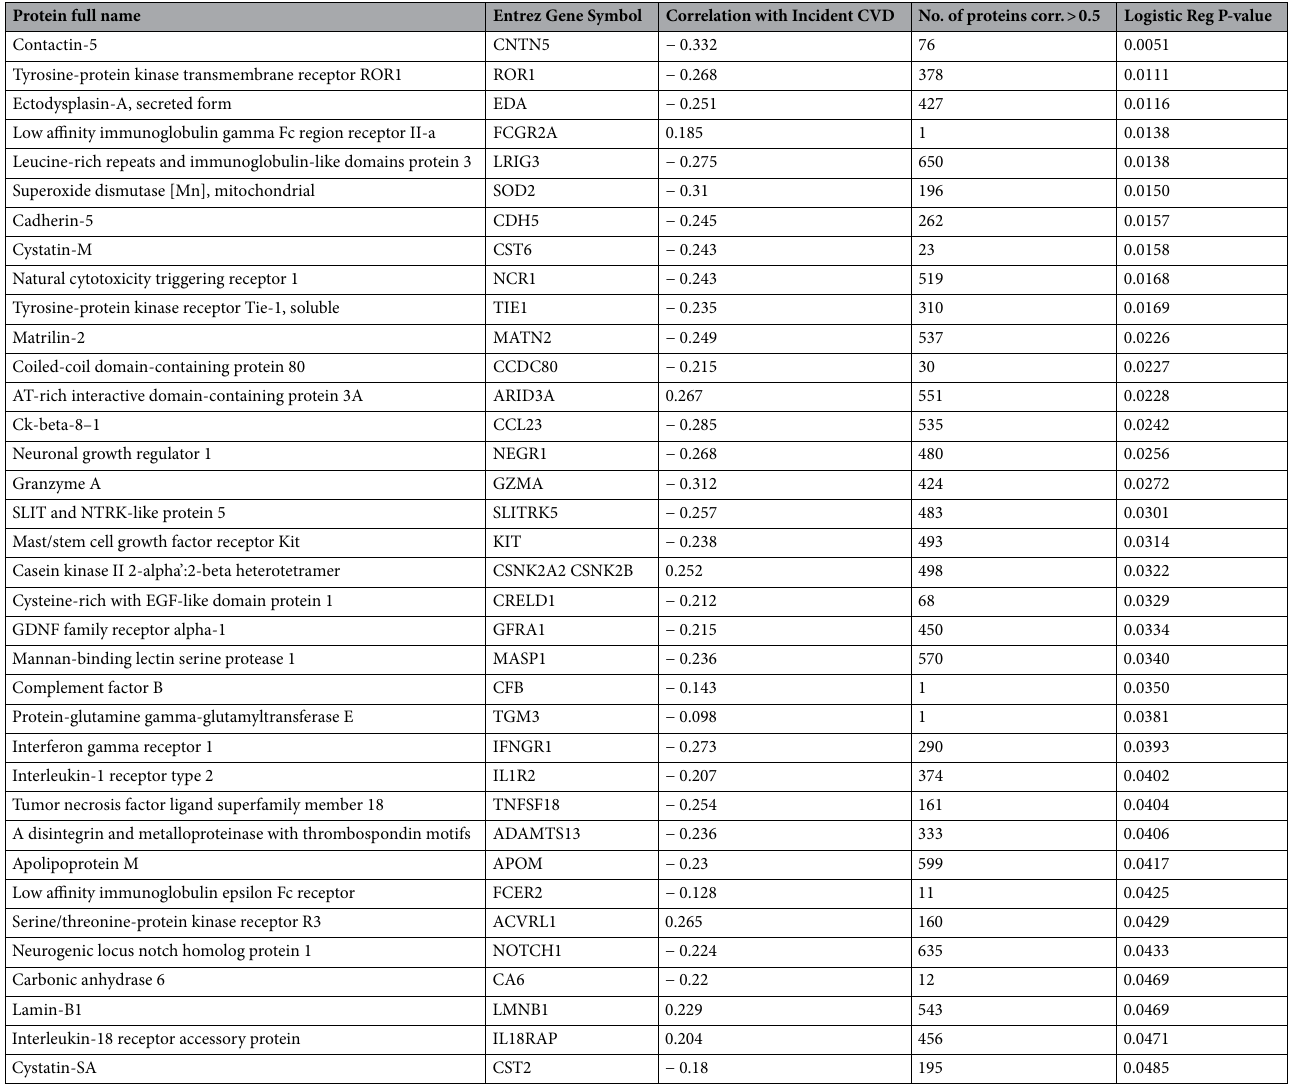
Table 2. Univariable logistic regression for the selection of top 36 proteins (p-value < = 0.05) associated with incident CVD. Correlation with Incident CVD is calculated using the Spearman correlation coefficient between each protein and Incident CVD. The # proteins corr > 0.5 indicates the number of other proteins that correlate with this protein at 0.5 or higher. Logistic Regression p-value is Wald chi-square p-value of univariable logistic regression modeling incident